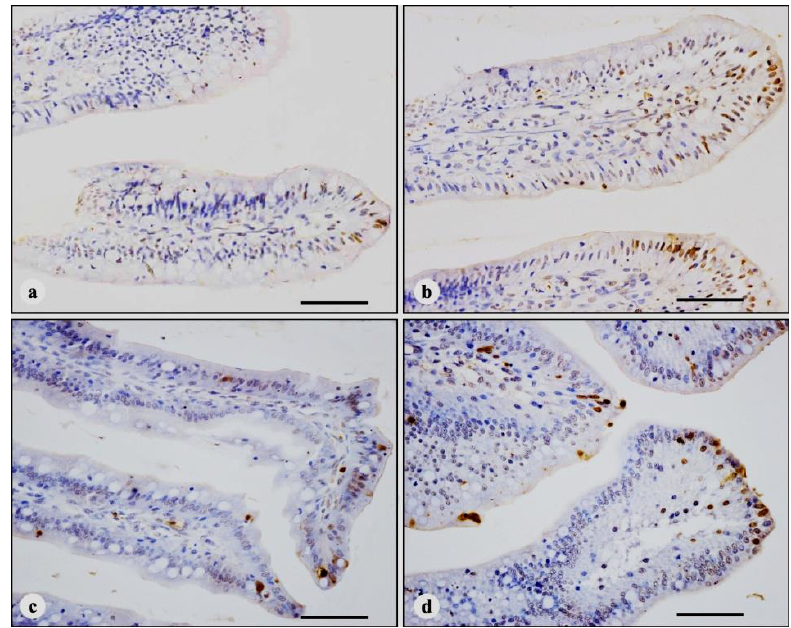
Figure 1. TUNEL-positive cells in the apical regions of jejunal villi at 14 days of age, immunohistochemistry stain. ( a ) in control broiler; ( b ) in AFB 1 broiler, the number of TUNEL-positive cells is increased, compared with control broiler; ( c ) in + Se broiler, the number of TUNEL-positive cells is not obviously changed compared with control broiler; ( d ) in AFB 1 + Se broiler, the number of TUNEL-positive cells is increased compared with control broiler, but, decreased compared with AFB 1 broiler. Bars = 50 μm.